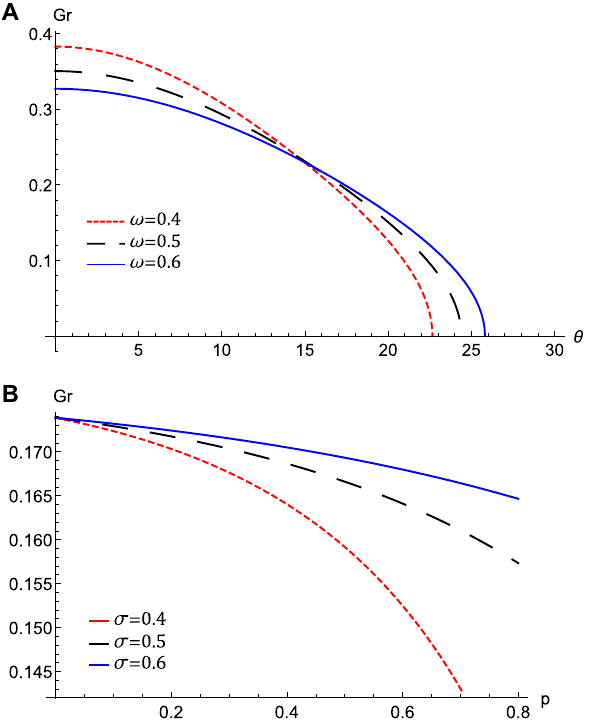
Figure 7. The variation of the growth rate, Gr , that represented by equation ( 30 ) at l ξ = 0.7, l η = 0.4, M = 0.4 , H e = 0.4 , and H p = 0.6 , ( A ) against θ for different values of ω at σ = 0.2 , p = 0.4 , ( B ) against p for different values of σ at ω = 0.5 , θ = 20